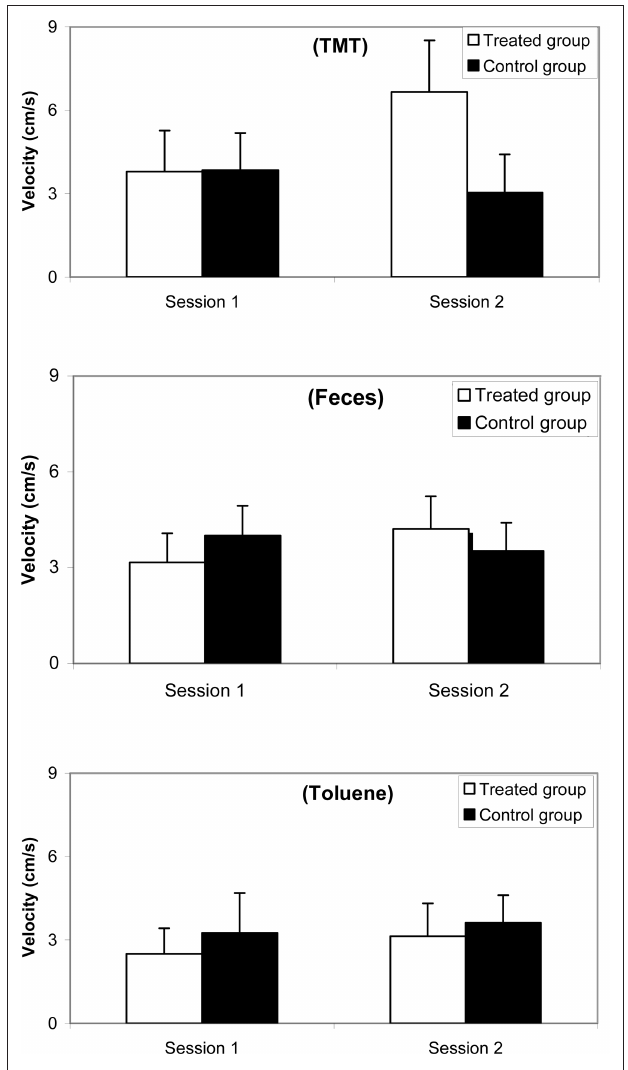
Figure 4 | Comparative velocity (mean and standard error) between synthetic 10% TMT, natural fox feces, and 10% toluene odorant conditions for a female mice group ( n = 10) before (Session 1, 1 week before treatment) and after (Session 2, 3 days after treatment) ZnSO intranasal perfusion and for a control female mice group ( n =